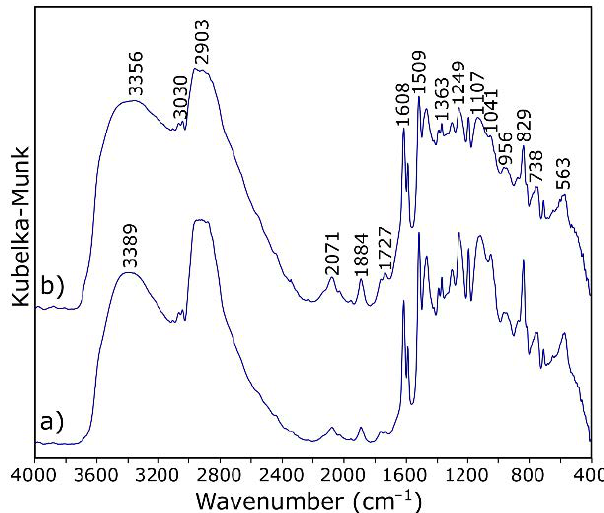
Figure 6. DRIFT spectra of ( a ) epoxy resin and ( b ) epoxy resin modified by graphene oxide.